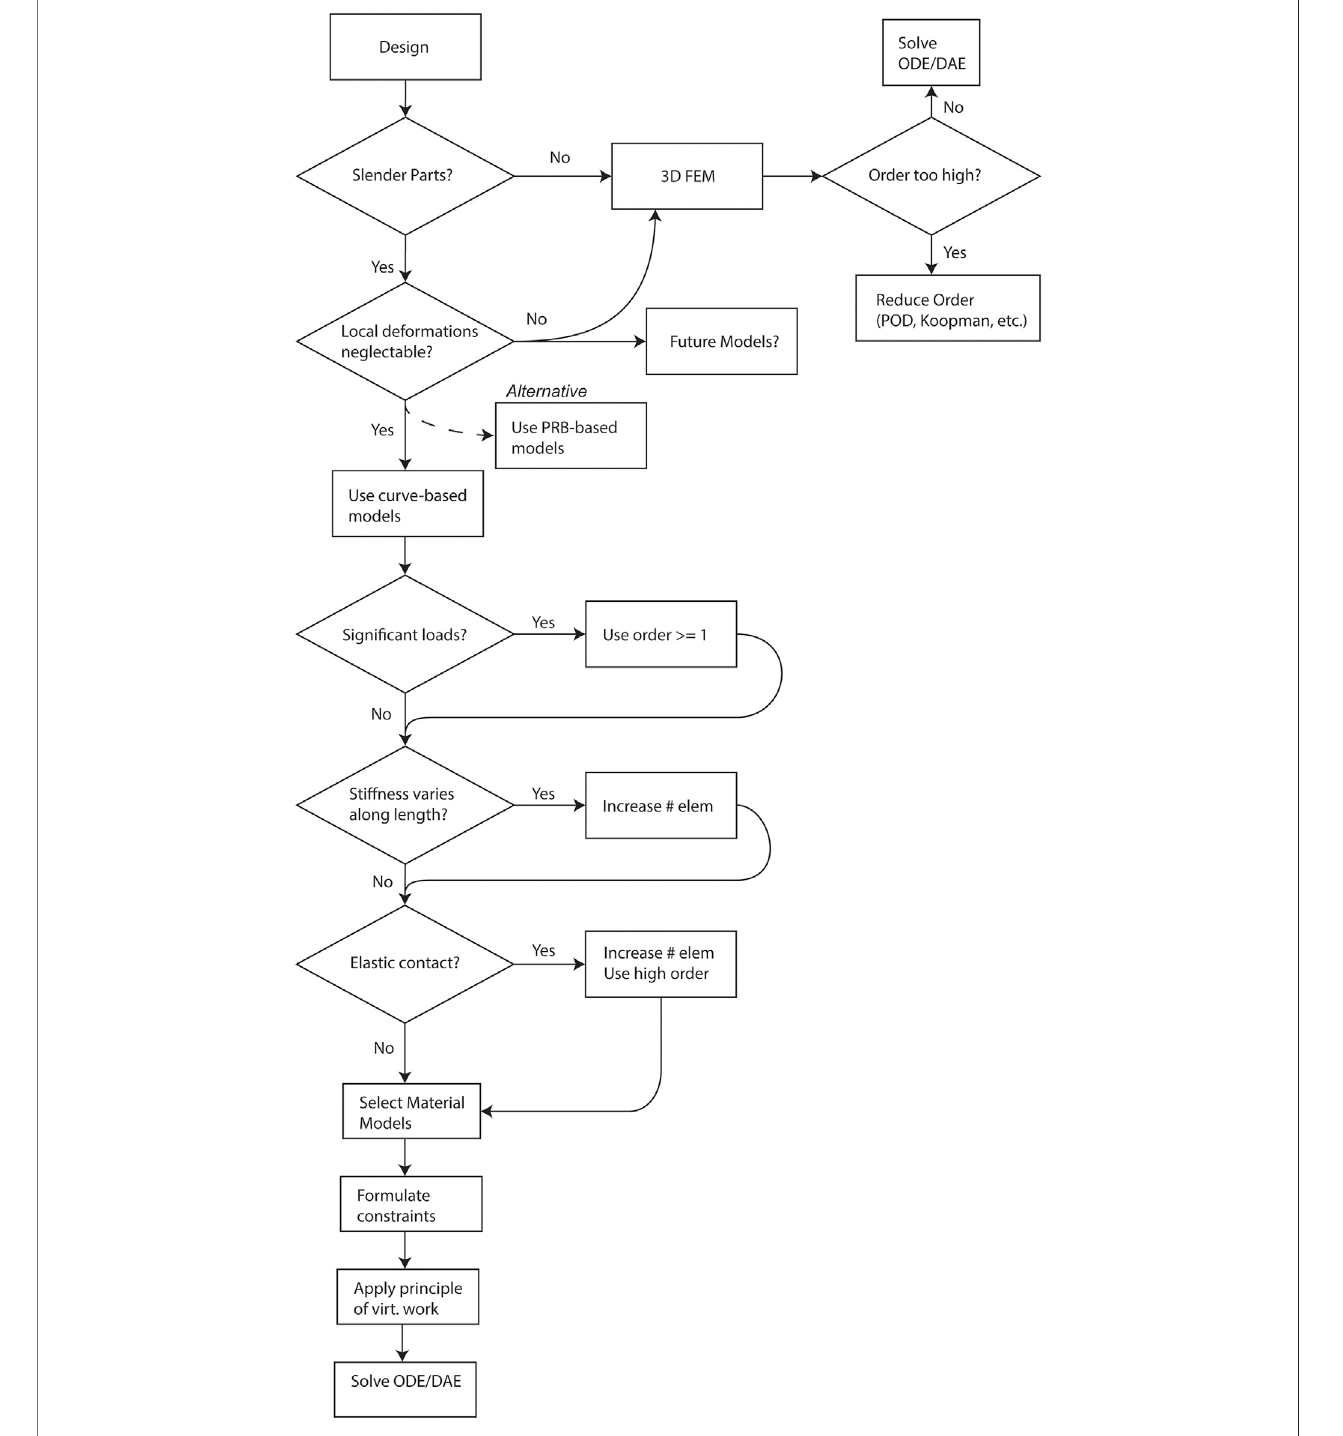
FIGURE 5 | Flowchart depicting the modeling decisions to be made when selecting a model type for a biomedical continuum robot.